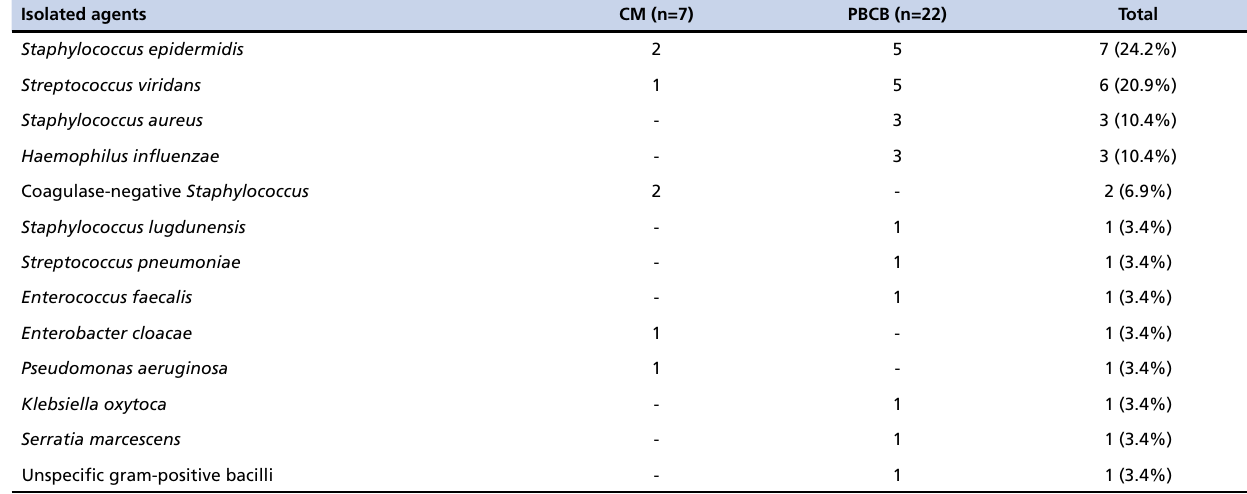
Table 1 - Isolated agents from vitreous samples from patients with acute postoperative endophthalmitis using the conventional method (CM) and pediatric blood culture bottles